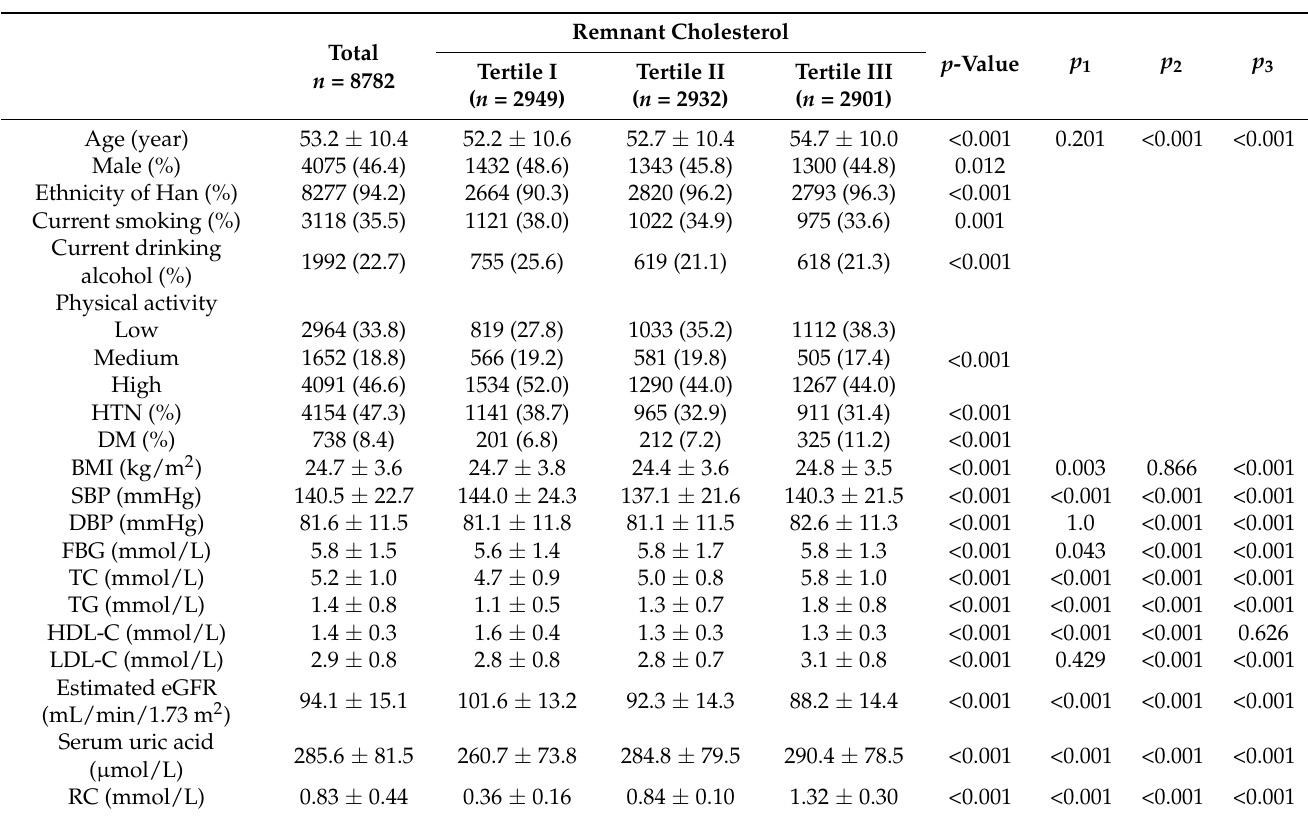
Table 1. Baseline characteristics by tertiles of remnant